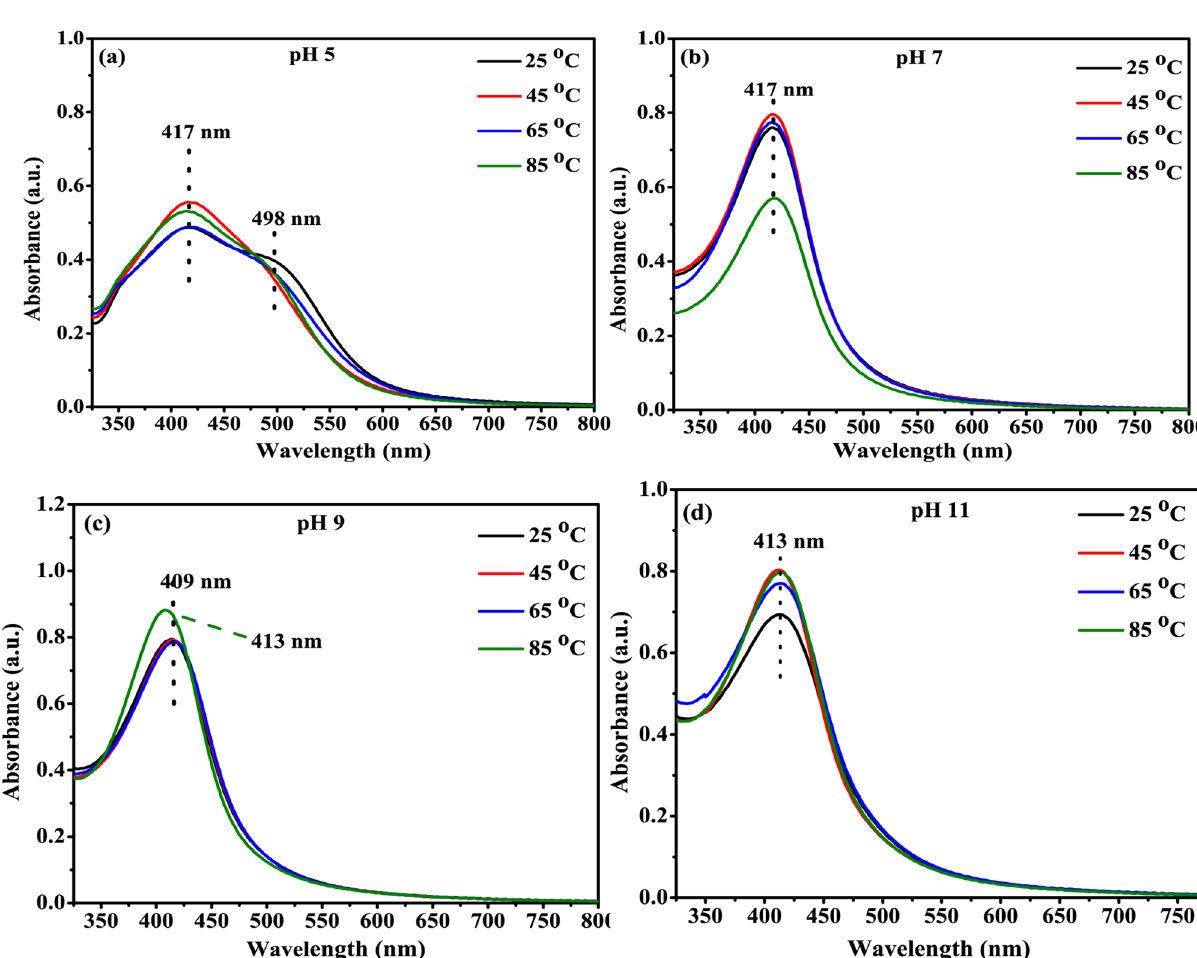
Figure 2. ( a – d ) UV–Vis absorption spectra of silver nanoparticles synthesized at different temperature for different pH